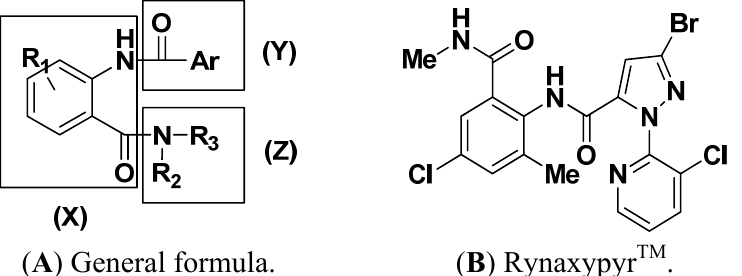
Figure 1. Chemical structures of anthranilic diamide